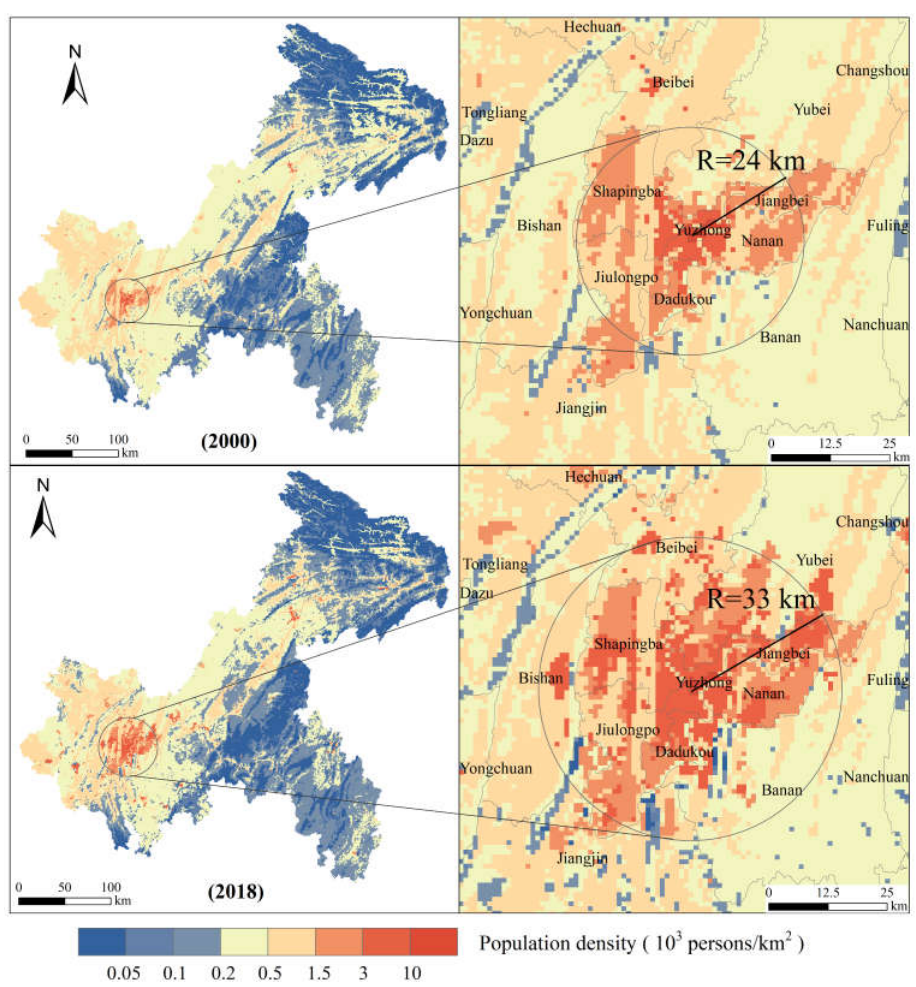
Figure 8. High-population-density regions in Chongqing in 2000 and 2018. The low-altitude zone had the highest average population density and population growth while trending toward agglomeration (Table 6). The average population density here increased from 550.58 to 647.08 people/km 2 from 2000 to 2018, a total population increase of 3.16 million. The growth rate was fastest from 2010 to 2015, increasing by 134.69 × 10 4 people in only five years. In contrast, the medium- and high-altitude